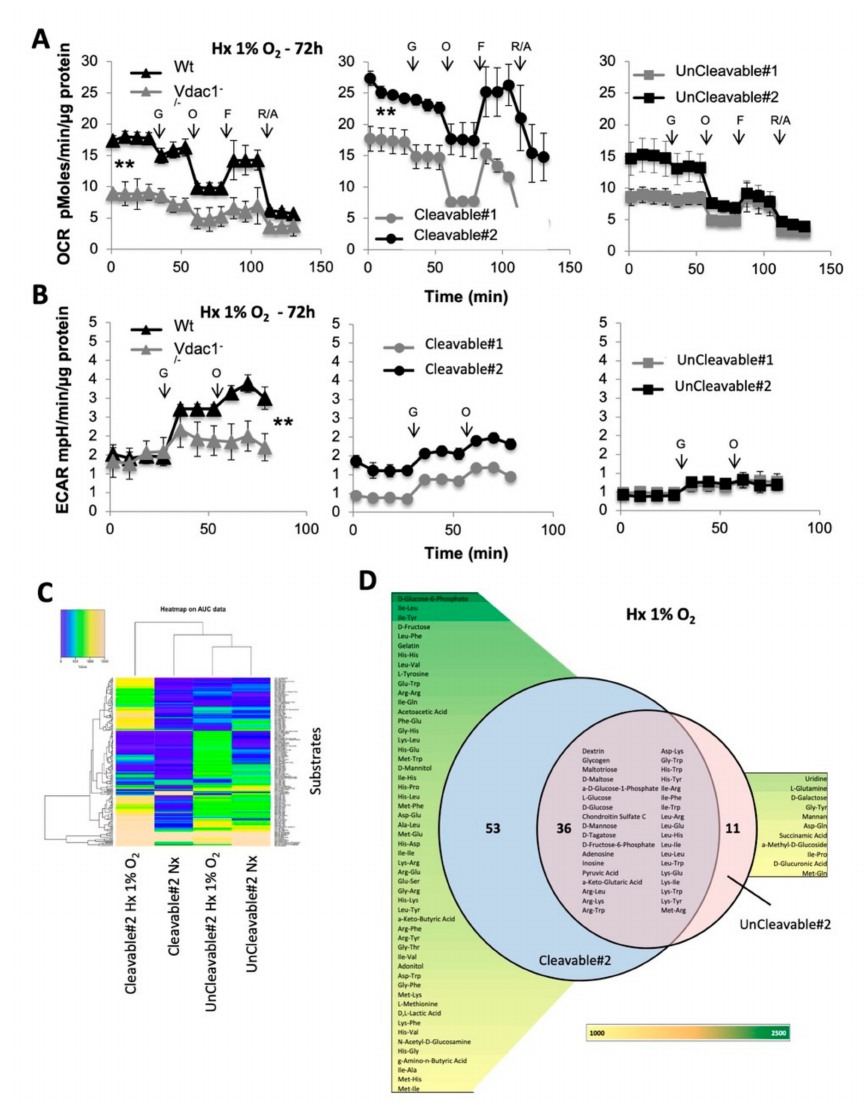
Figure 2. Metabolic characteristics of the cleavable and uncleavable forms of VDAC1 in 1% O 2 hypoxia. ( A ) Respiratory control of Wt and Vdac1 − / − cells (left panel), Cleavable#1 / #2 (middle panel) and UnCleavable#1 / #2 (right panel). OCR was measured in real time with the XF24 analyzer in Hx 1% O 2 . Cells were deprived of glucose for 1h, then glucose (G), oligomycin (O), FCCP (F), and Rotenone + Antimycin A (R / A) were injected at the indicated times. The mean ± SEM is representative of at least three independent experiments carried out in quadruplicate. ( B ) ECAR in Hx of Wt and Vdac1 − / − cells (left panel), Cleavable#1 / #2 (middle panel) and UnCleavable#1 / #2 cells (right panel) was evaluated with the XF24 analyzer. Cells were deprived of glucose for 1 h, then glucose (G) and oligomycin (O) were injected at the indicated times. The mean ± SEM is representative of at least three independent experiments carried out in quadruplicate. ( C ) Heatmap showing the 160 substrates that were di ff erently metabolized by Cleavable#2 and UnCleavable#2 in normoxia and hypoxia. The color key scale for each substrate is based on dye reduction quantified by Omnilog units. A yellow color indicates strong positive substrate metabolization, a green color moderate metabolization and a blue color indicates no substrate metabolization. Data area under the curve (AUC) < 500 have been excluded. ( D ) Venn diagram comparing metabolic phenotyping of Cleavable#2 and UnCleavable#2 in hypoxia. Data AUC > 750. ** indicates p <